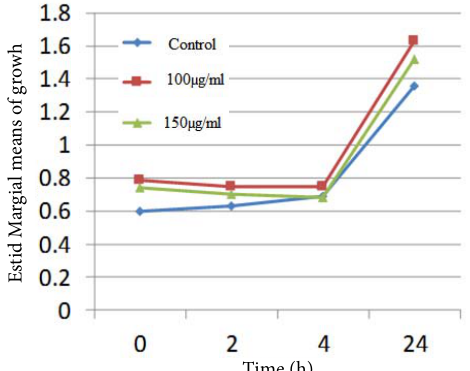
Fig. 1: Comparison of OD changes proportional to the concentration of silver nanoparticles at different times after treatment